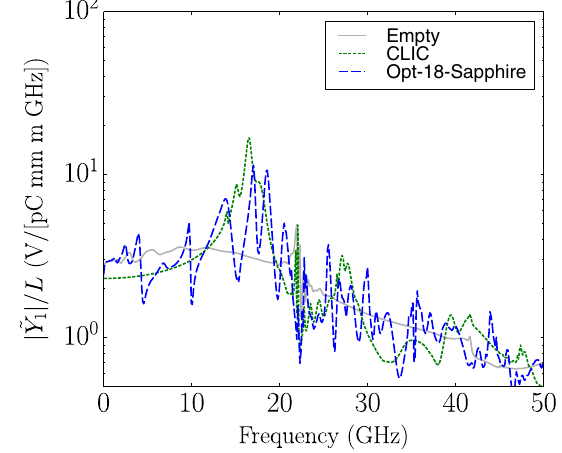
FIG. 13. Monopole HOMs are numerous but suppressed in the Opt-18-Sapphire cavity.